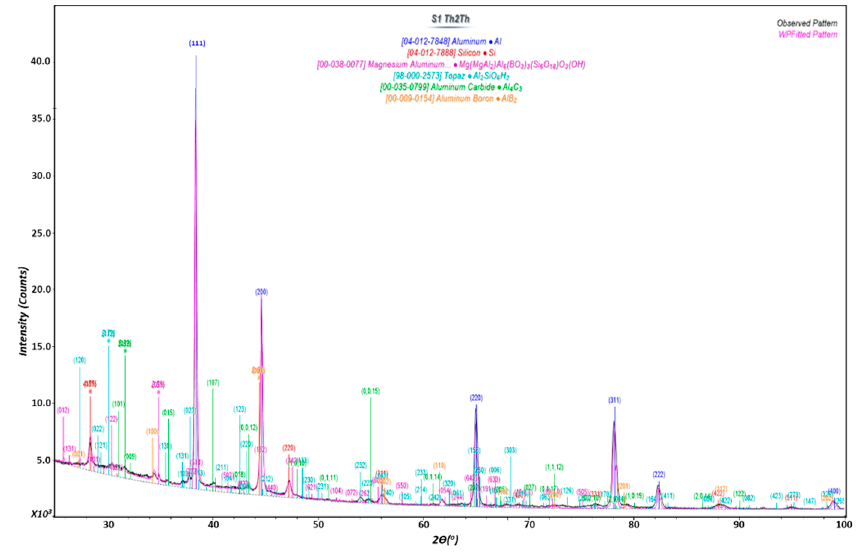
Figure 8. XRD test of mixed B 4 C and AlSi10Mg sample.